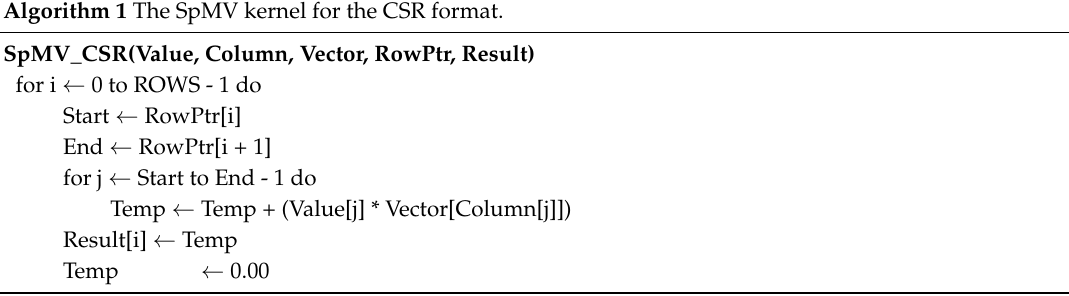
Algorithm 1 The SpMV kernel for the CSR